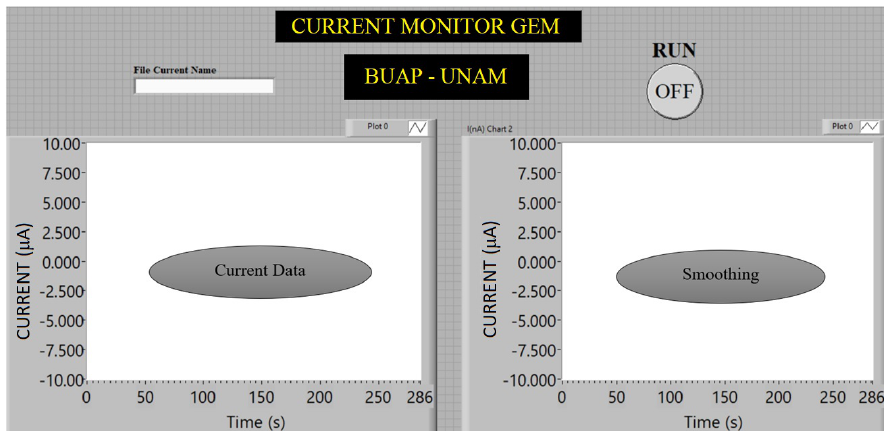
Figure 5. User interface of the current monitoring system.